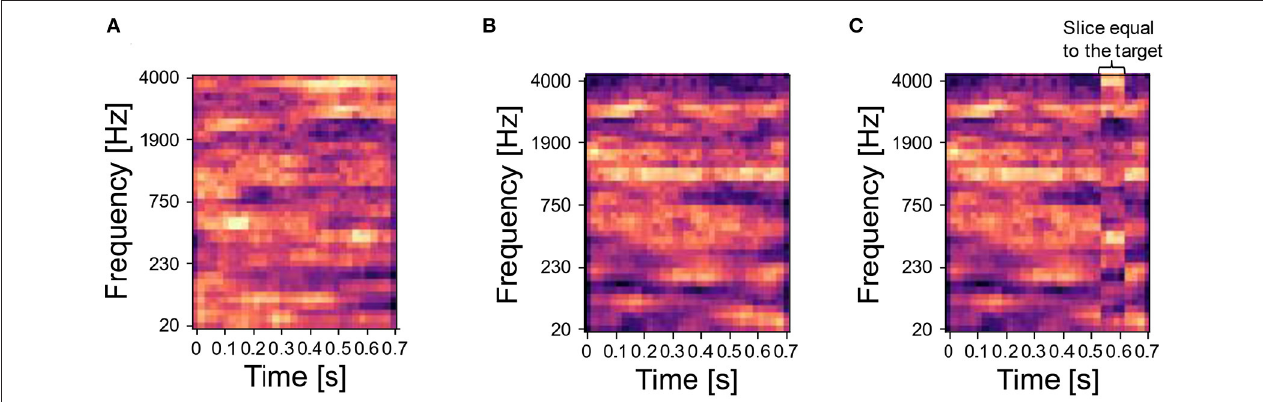
FIGURE 2 | Synthesized sounds—target and associated distractor. (A) Spectrogram of one target sound. (B) Step 1 to build the spectrogram of an incorrect probe related to the target in (A) : a sound is randomly selected from the same Gaussian distribution generating the target. (C) Step 2 to build the incorrect probe: after the sampling, a randomly selected time slice equal to 1/8 of the sound duration is set to be equal to the target. In the figure, the temporal slice is the vertical stripe around time 0.5 s.